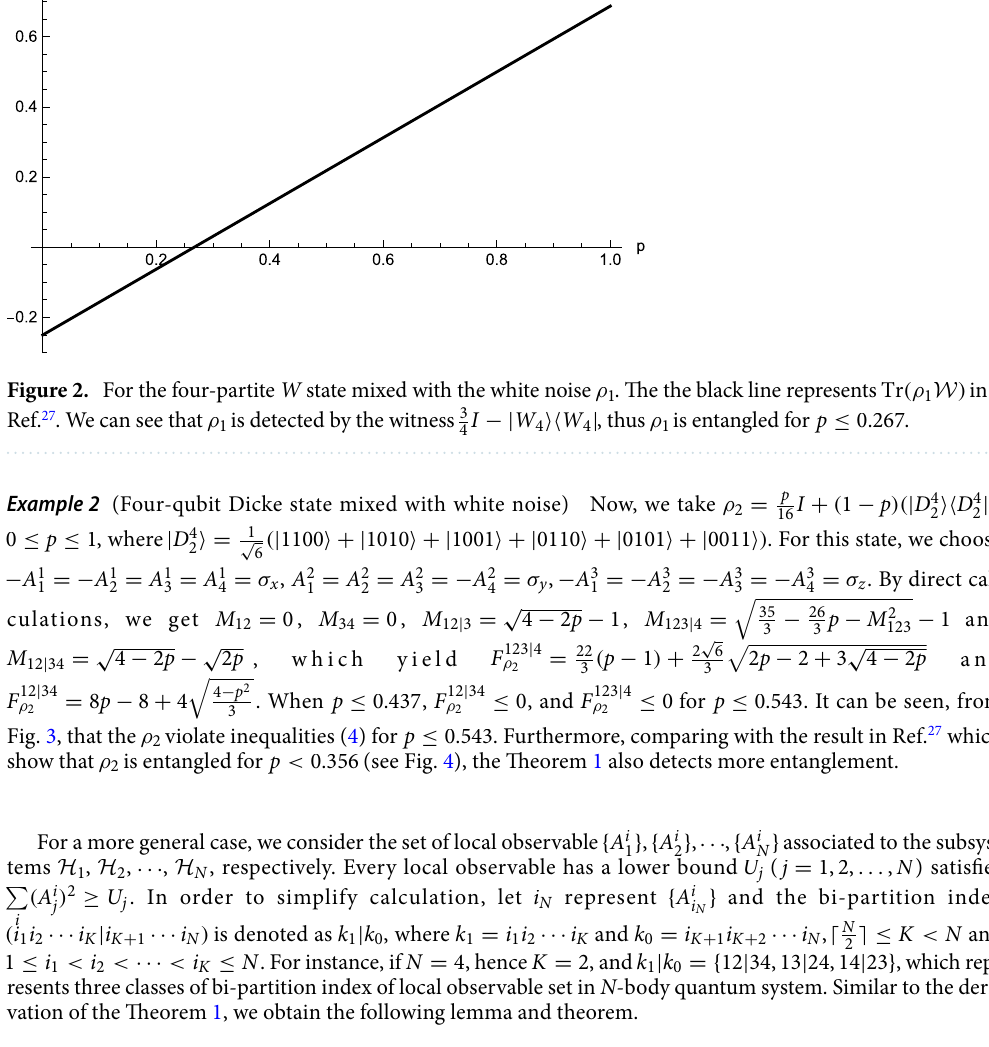
12 34 | ρ 1 in Theorem 1. We can see that when p 0.3605 . ≤